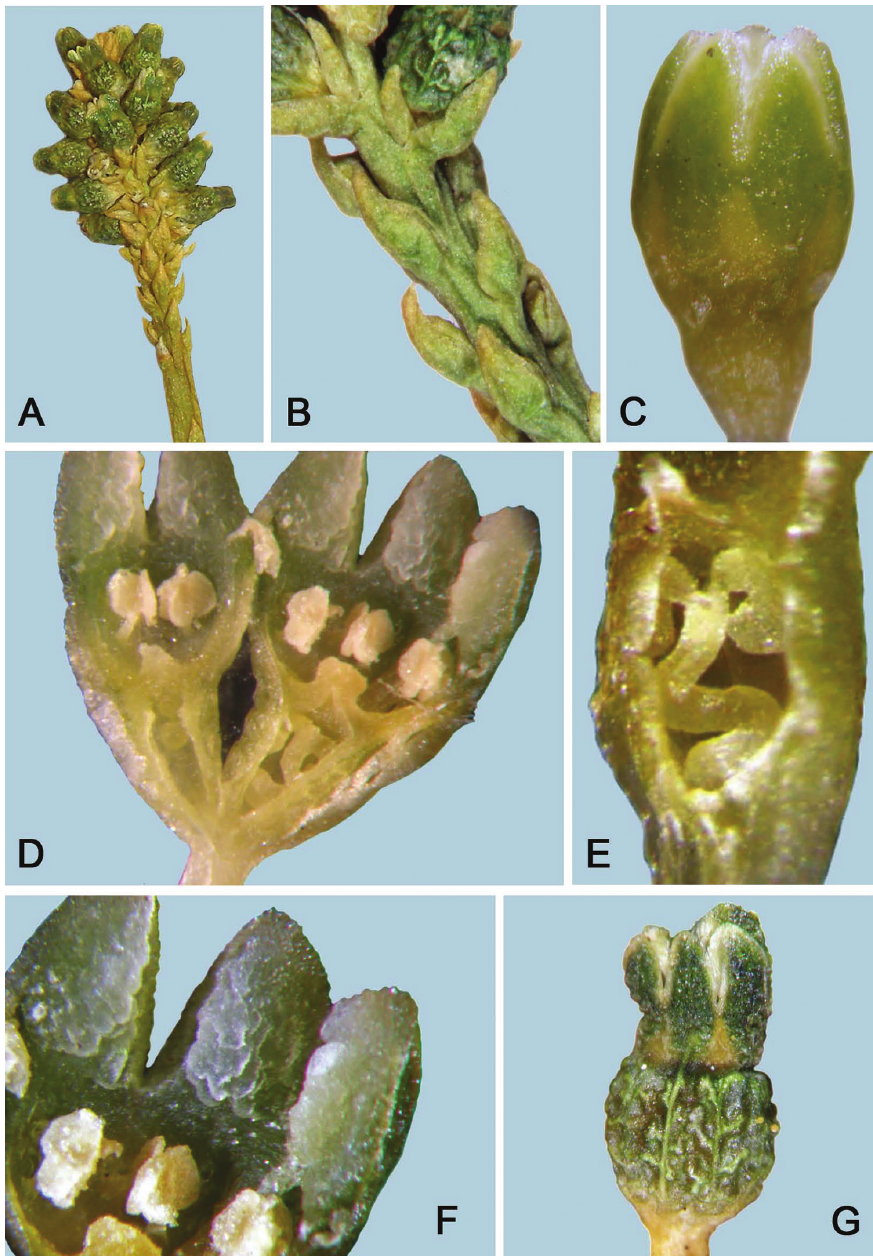
Figure 3. Thesium nautimontanum from the type herbarium specimen. For dimensions, see Figure 2 . A spicate inflorescence subtended by bracts B close-up of inflorescence bracts C flower, lateral view, show- ing triangular external glands in corolla lobe sinuses D flower longitudinal section E ovary longitudinal section showing twisted placental column and ovules (one ovule removed to visualise the placentation) F close-up view of interior surface of corolla lobes showing unusual fleshy tissue on inner surface of corolla lobes G young fruit showing persistent corolla and reticulate outer wall of